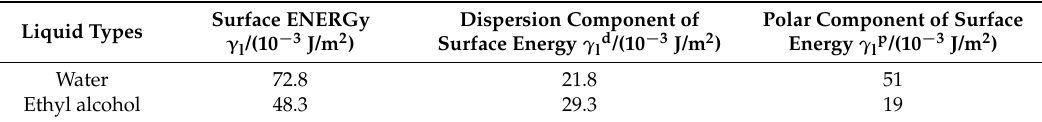
Table 3. Parameters of the surface energy of water and ethyl alcohol.